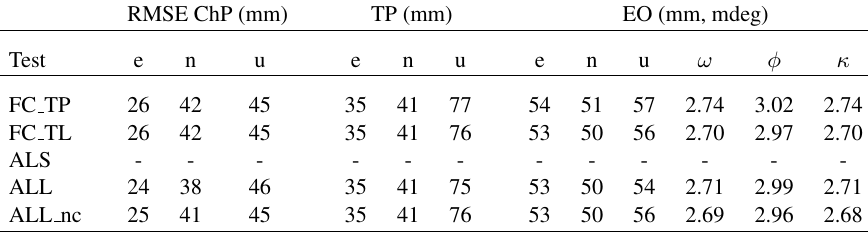
Table 8: Test results: FC.